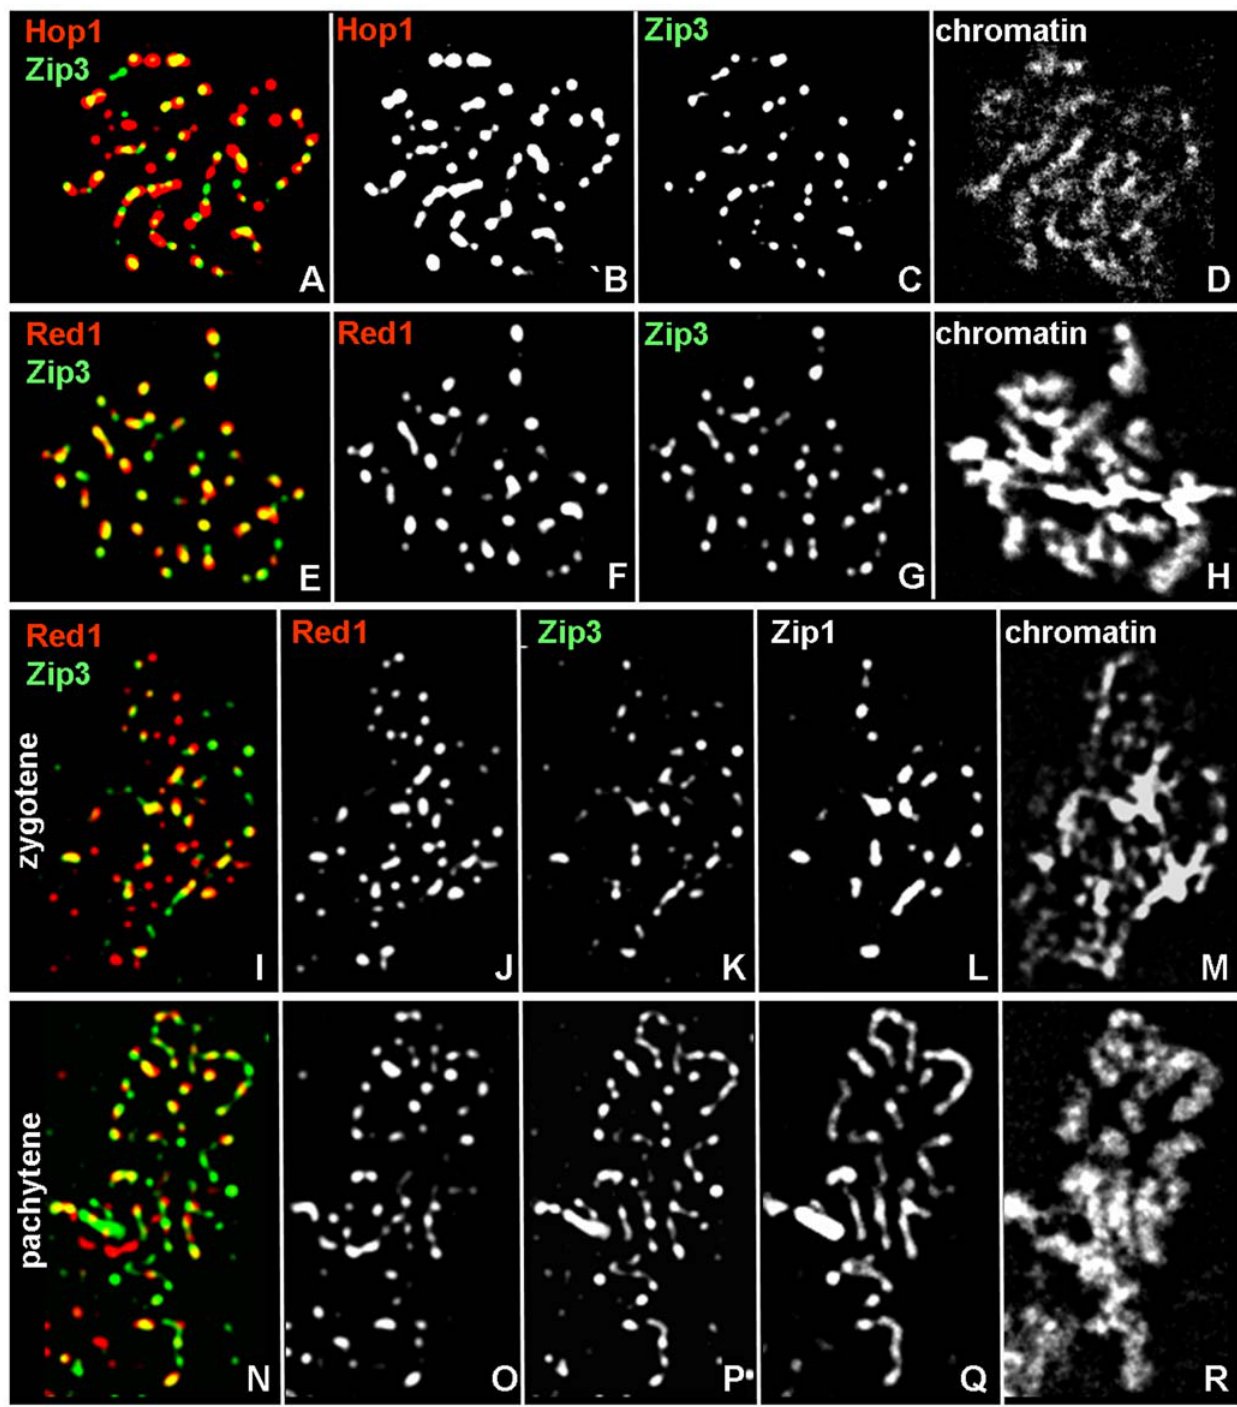
Figure 3. Association of axis components Hop1 and Red1 with CO–designation marker Zip3 at different stages of synapsis. (A–D) Spread pachytene nucleus stained with antibodies against Hop1 and Zip3-GFP. (E–H) Spread pachytene nucleus labeled with antibodies against Red1-HA and Zip3-GFP. (I–R) Spread nuclei from time course shown in (E–H) stained with antibody against Zip1 as well as Red1-HA and Zip3-GFP. (I– M) Spread zygotene nucleus. (N–R) Spread pachytene nucleus. Colors are indicated by the corresponding labels. Yellow colors in (A,E,I,N) indicate overlap between the indicated protein signals. Meiosis was induced at 33 u C.